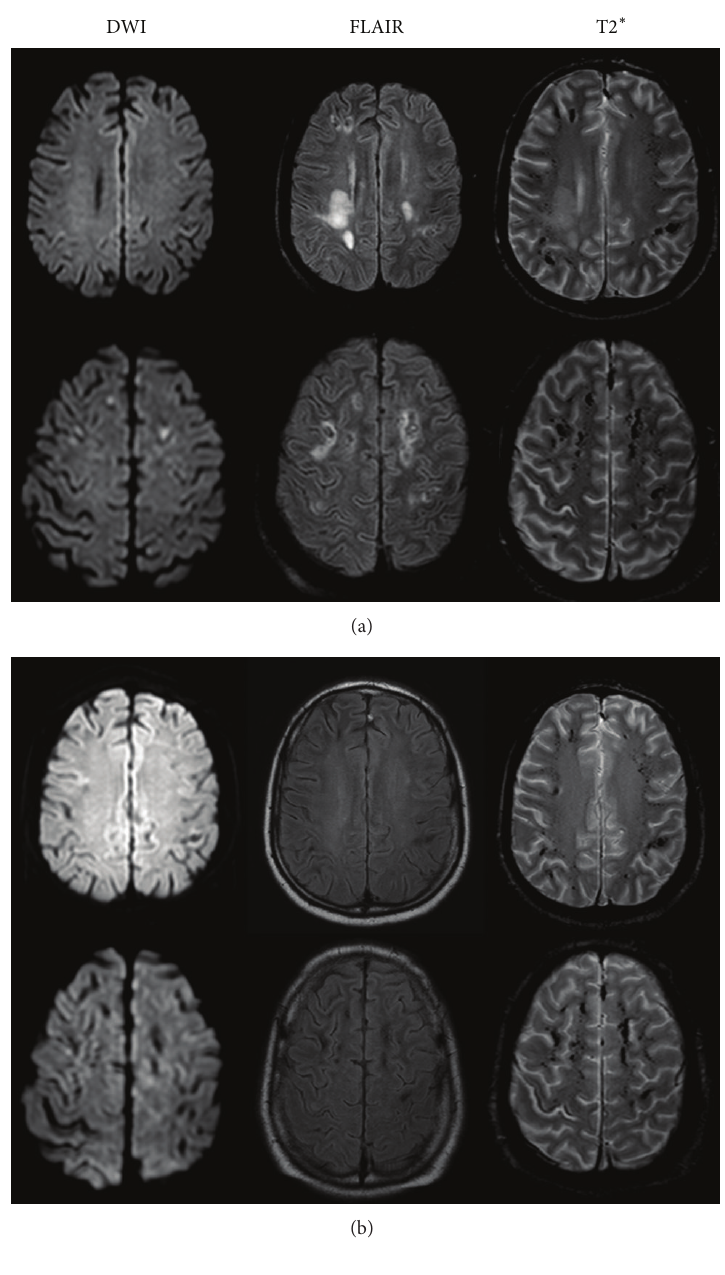
Figure 5: MRI manifestations of Patient 3. (a) Deep white matter edema in frontoparietal lobe with hemorrhagic lesions. (b) Resolution of brain edema with residual hemorrhagic